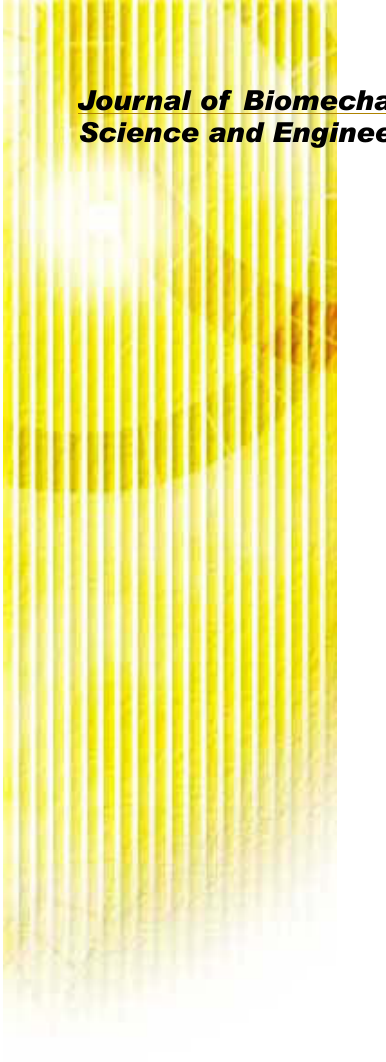
Experimental setup of the developed device for cellular indentation. (a) Schematic diagram of proposed cellular indentation experimental setup. The deformation of the cell can be imaged and measured using an optical microscope coupled with a CCD camera, and its elastic property can be estimated based on the Hertz contact model. (b) Proposed experiment with a mouse egg